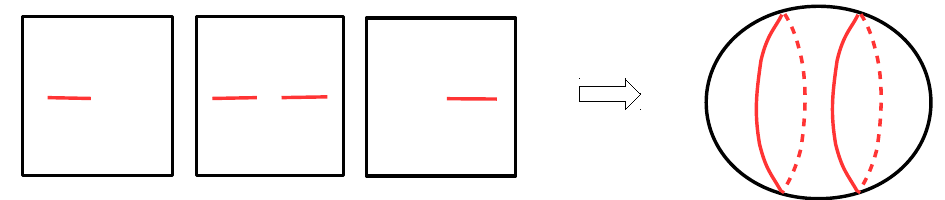
Figure 3 . The gluing of three complex planes. The branch cuts are represented by red